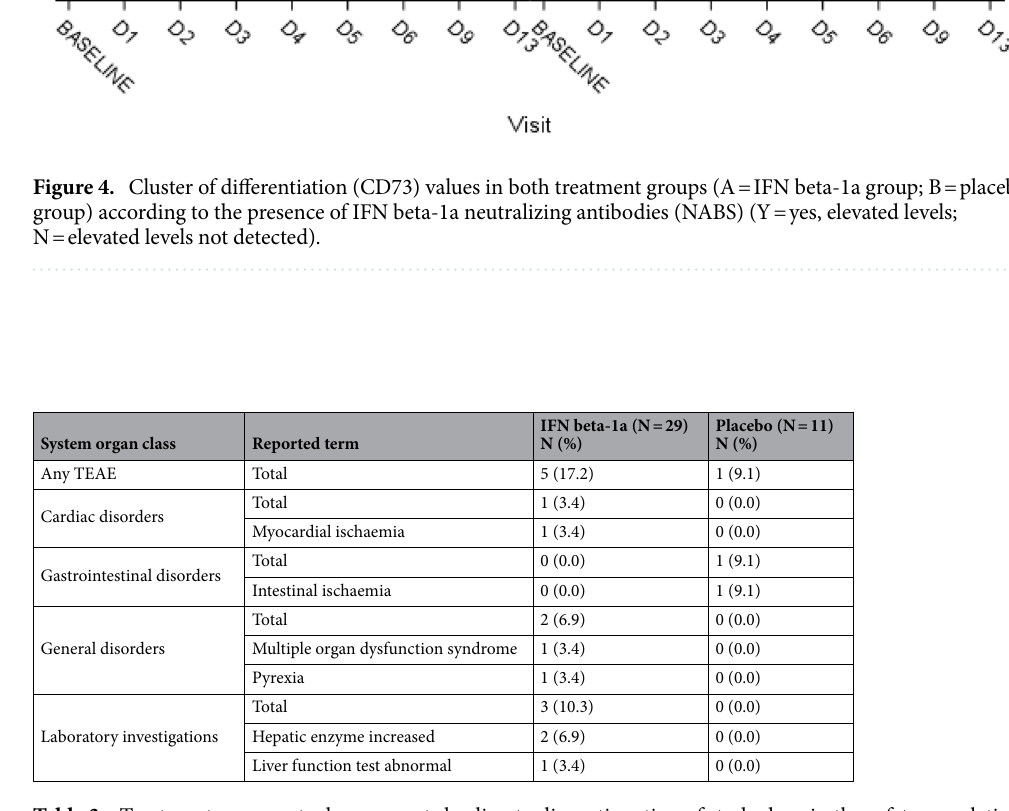
Table 3. Treatment-emergent adverse events leading to discontinuation of study drug in the safety